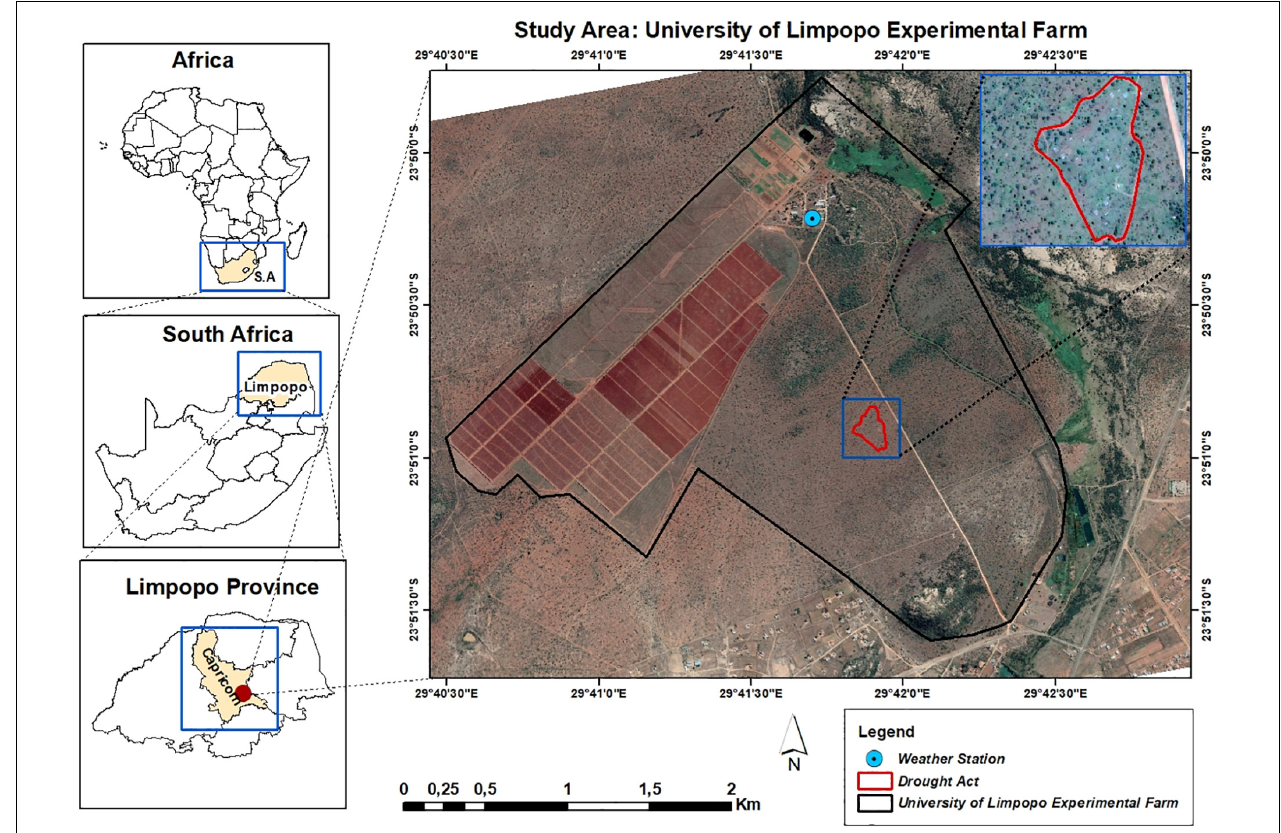
FIGURE 1 | Location of the DroughtAct experiment at the University of Limpopo Experimental Farm in South Africa’s Limpopo